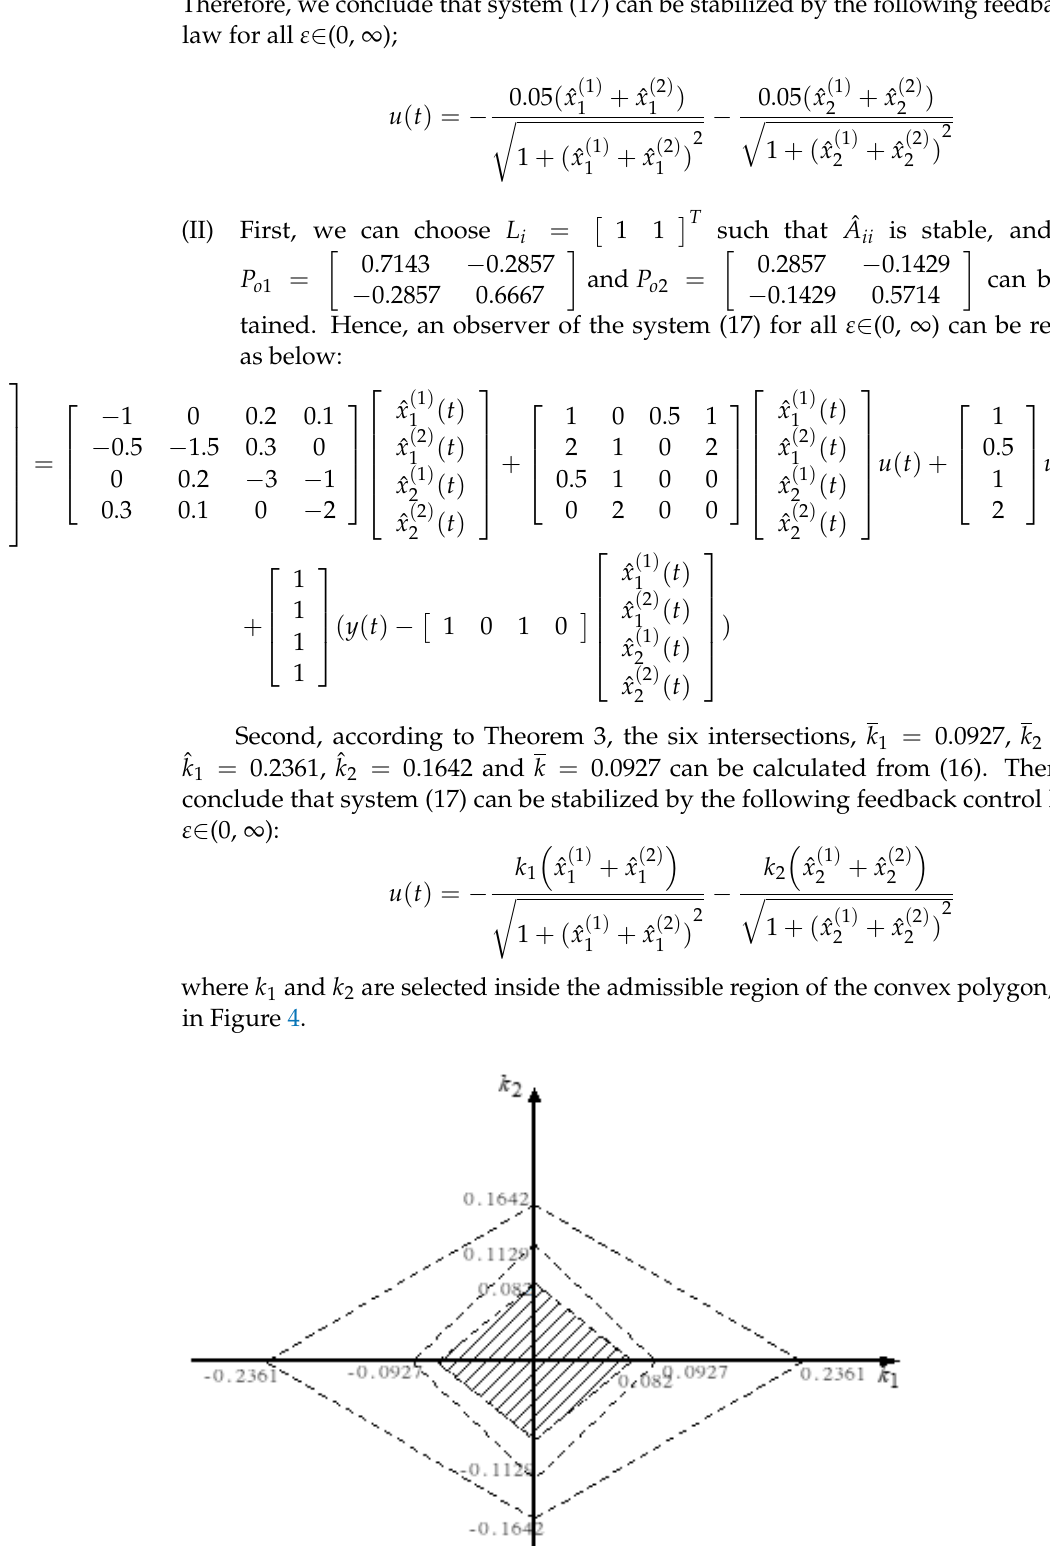
Figure 4. The admissible region k